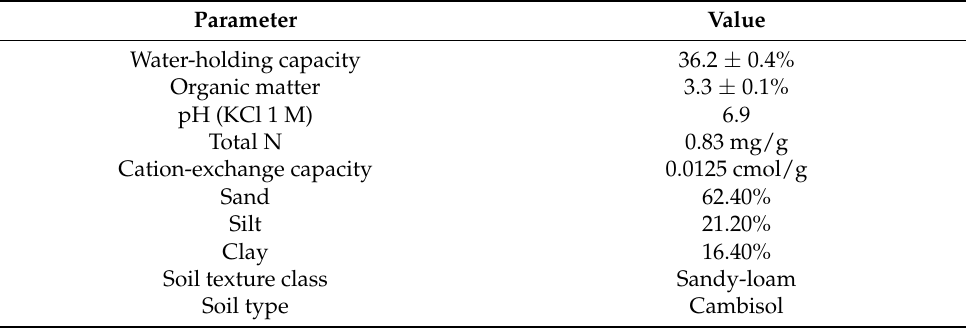
Table 1. Chemical and physical characterization of the test soil. Parameter